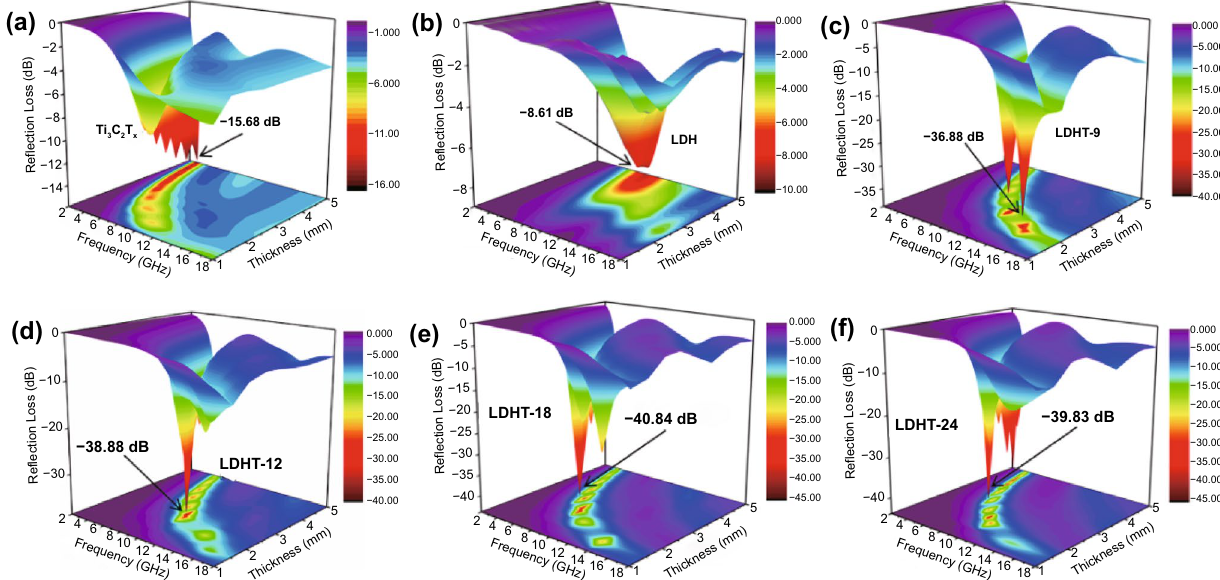
Fig. 6 3D RL values of a Ti 3 C 2 T x , b LDH, c LDHT‑9, d LDHT‑12, e LDHT‑18 and f LDHT‑24 composites with a filler content of 15 wt% at different